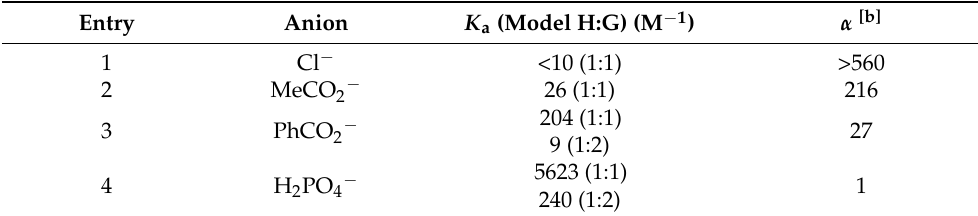
Table 1. Stability constants K a (M − 1 ) and selectivity factor α for host:guest complexes of receptor trans - 1 with anions [a]